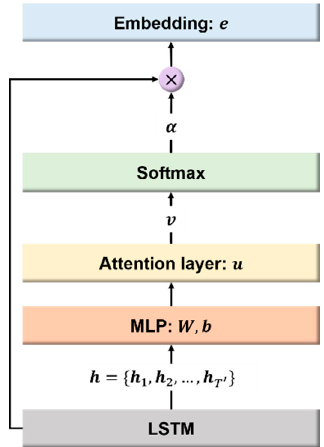
Figure 2. Block diagram of speaker embedding extraction using single-head attention; α , v , and h denote attention weight, attention layer output, and LSTM output respectively.